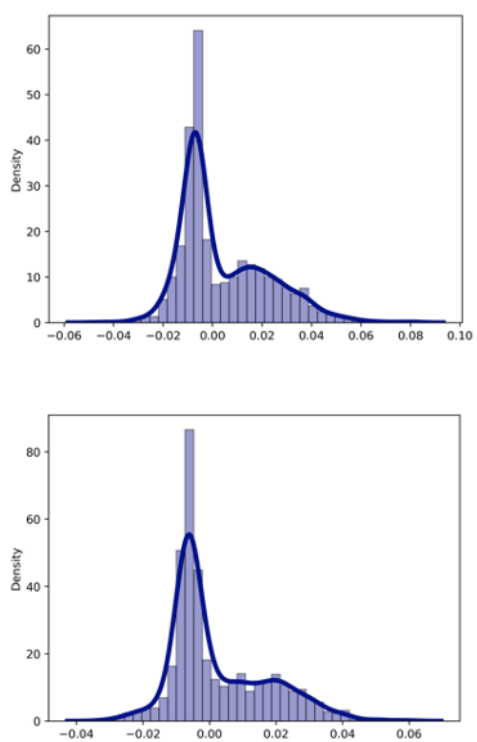
Figure 10. Distribution of weights of the baseline model (Top) and the model trained by real+synthetic samples